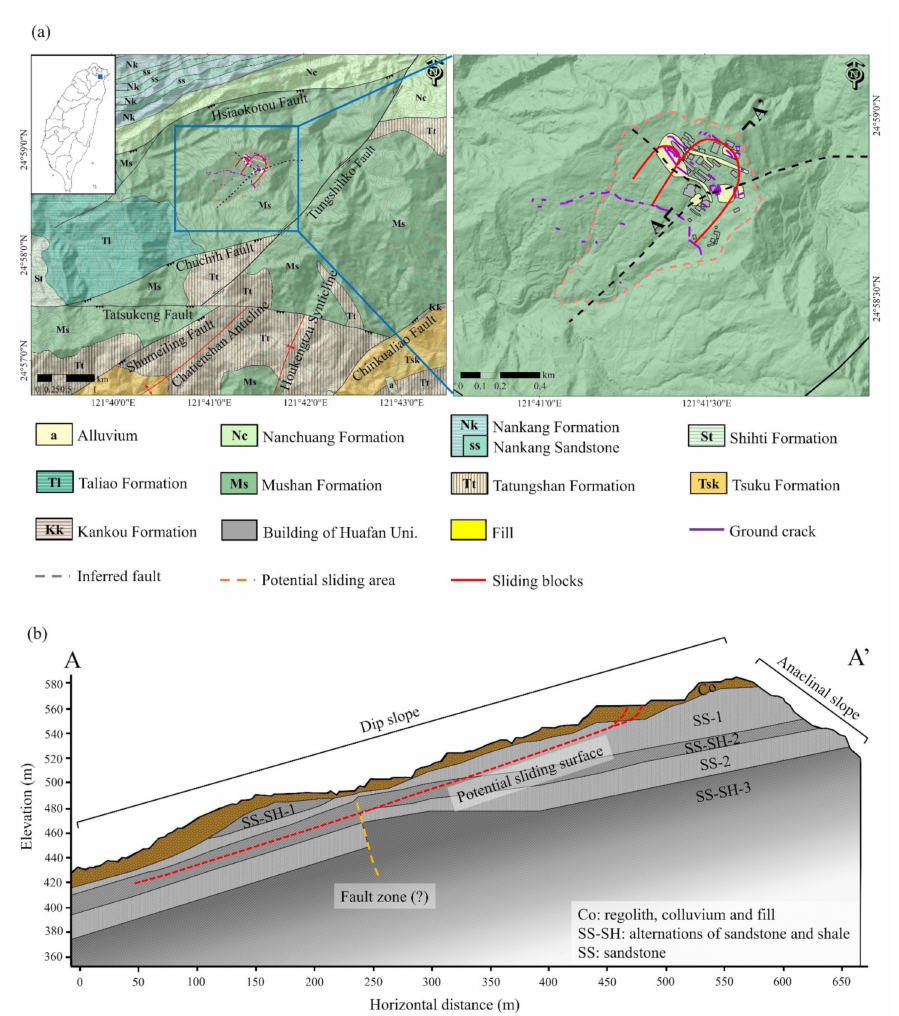
Figure 1. ( a ) Geological map of the Dalun Mountain area, which is located at the northern end of the Western Foothills belt in northern Taiwan. The dominant lithology of the study area is the Miocene Mushan Formation. Red lines indicate the areas of the two sliding blocks, while the orange dotted line indicates the potential landslide area determined from topographic features based on LiDAR-derived topography. The background topography is shown by shaded relief imagery processing from 20 m and 2 m digital elevation models (DEMs). ( b ) The geological profile is along line AA’, which is modified from [29]. The bedrock of this dip slope is composed of sandstone and alternations of sandstone and